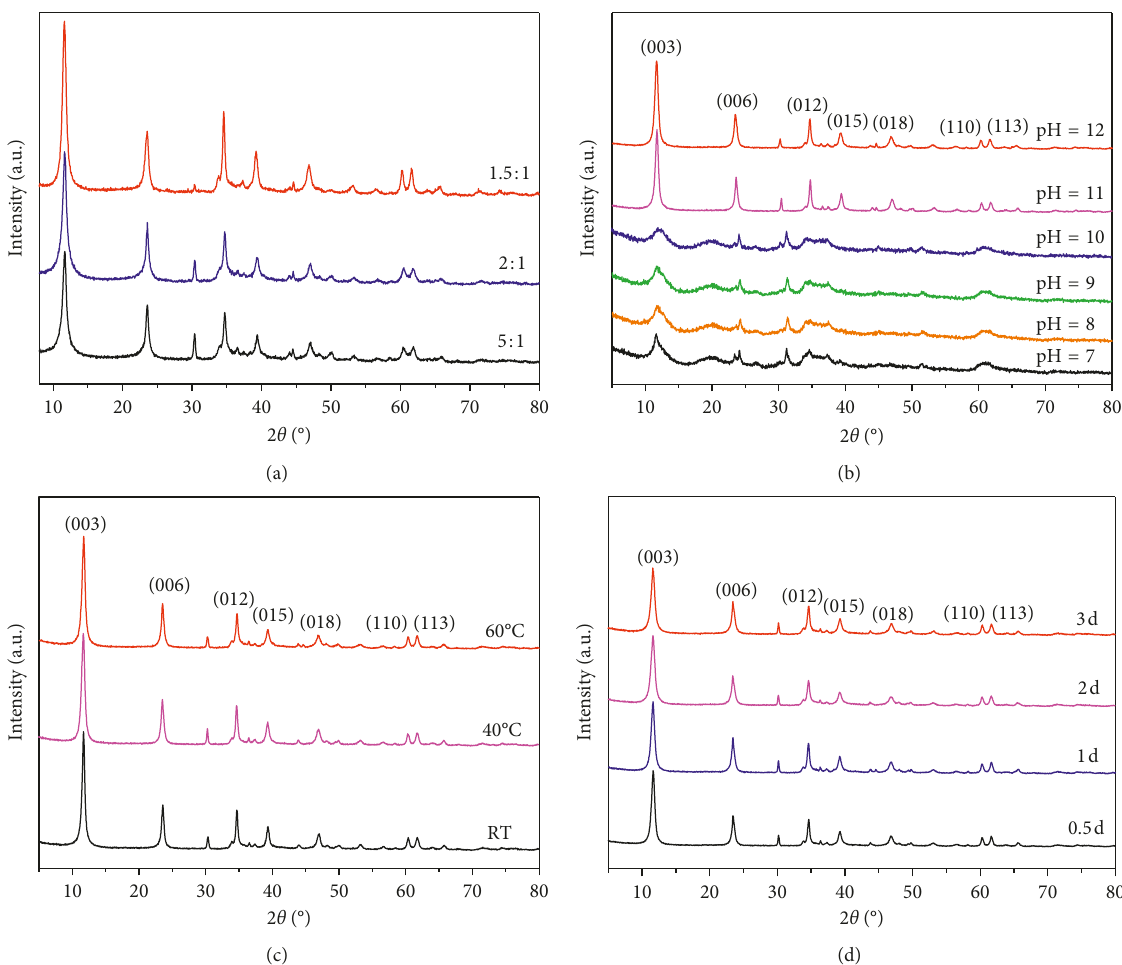
Figure 2: XRD pattern of Cu/Zn/Al-HTlc of different (a) Zn II /Al III molar ratios, (b) pH values, (c) aging temperatures, and (d) aging time